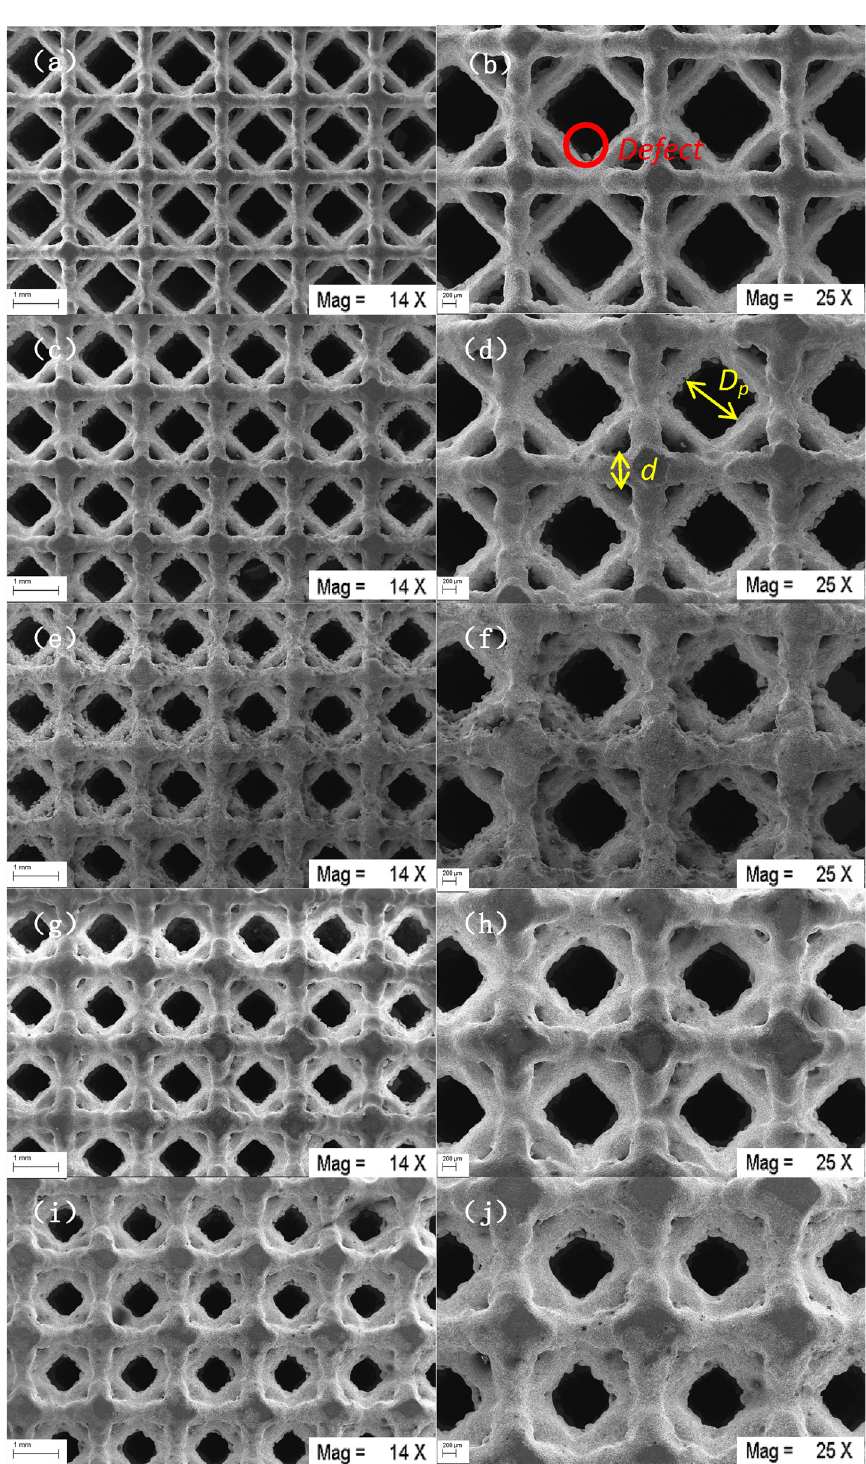
Figure 10: SEM surface topography of di ff erent sizes of 1.5 mm cells at 14 × and 25 × magni fi cation. ( a and b ) 0.4 mm edge diameter; ( c and d ) 0.45 mm edge diameter; ( e and f ) 0.5 mm edge diameter; ( g and h ) 0.55 mm edge diameter; and ( i and j ) 0.6 mm edge